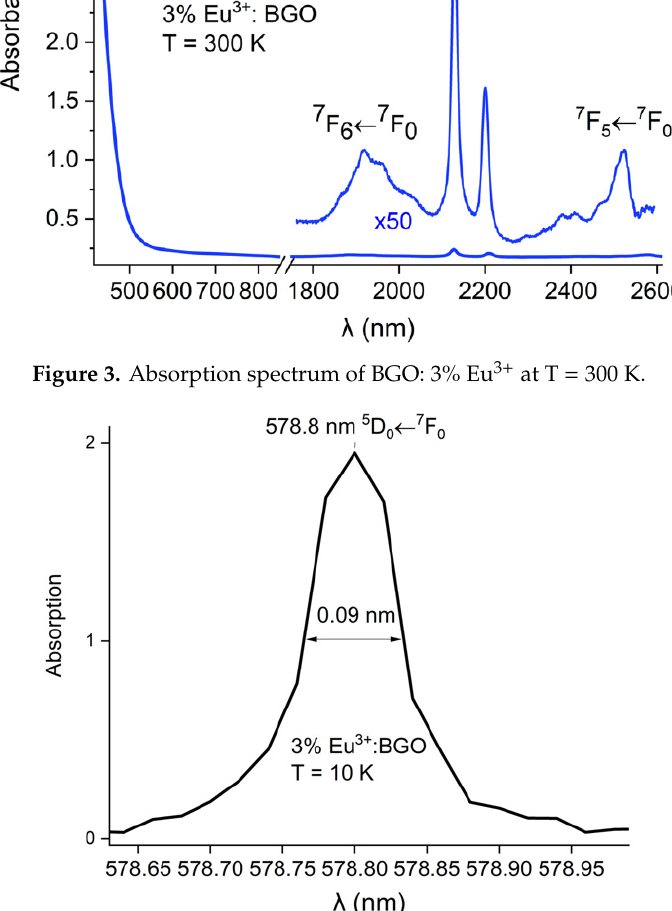
Figure 4. Low temperature (10 K) absorption spectrum where 5 D 0 ← 7 F 0 line is shown.